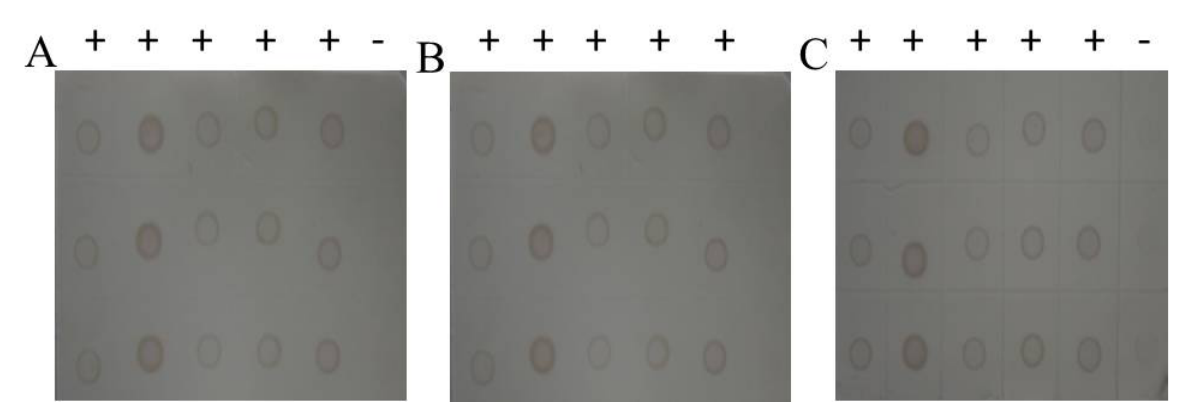
Figure 2. (A) 1:1000-fold antiserum dilution and 60 min second blocking time. (B) 1:1500-fold antiserum dilution and 60 min second blocking time. (C) 1:1500-fold antiserum dilution and 30 min second blocking